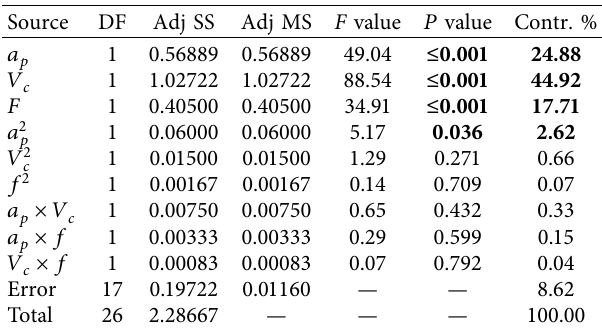
Table 8: Analysis of variance for sound intensity level.